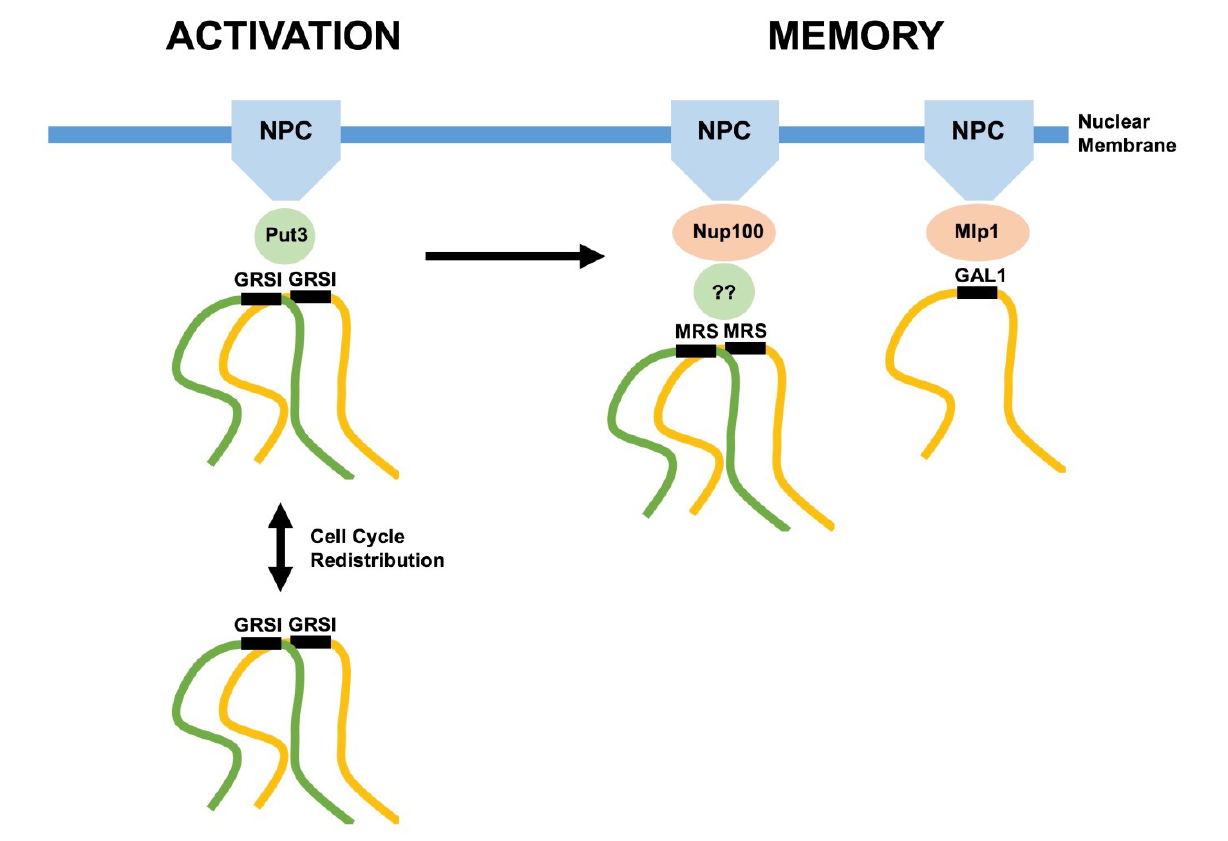
FIGURE 1: MRS-dependent interchromosomal clustering during epigenetic transcriptional memory. Portions of homologous chromo- somes (yellow, green) are depicted clustering via their respective DNA zip code elements, associating with intermediary proteins and nucle- ar pore complexes (NPC). GRSI-mediated clustering is retained throughout the cell cycle independently of nuclear membrane binding. Memory-based clustering is specific to given genes/zip codes, possibly by virtue of distinct NPC adapter proteins. Memory-based clustering is dependent on prior clustering via GRSI elements during the activation